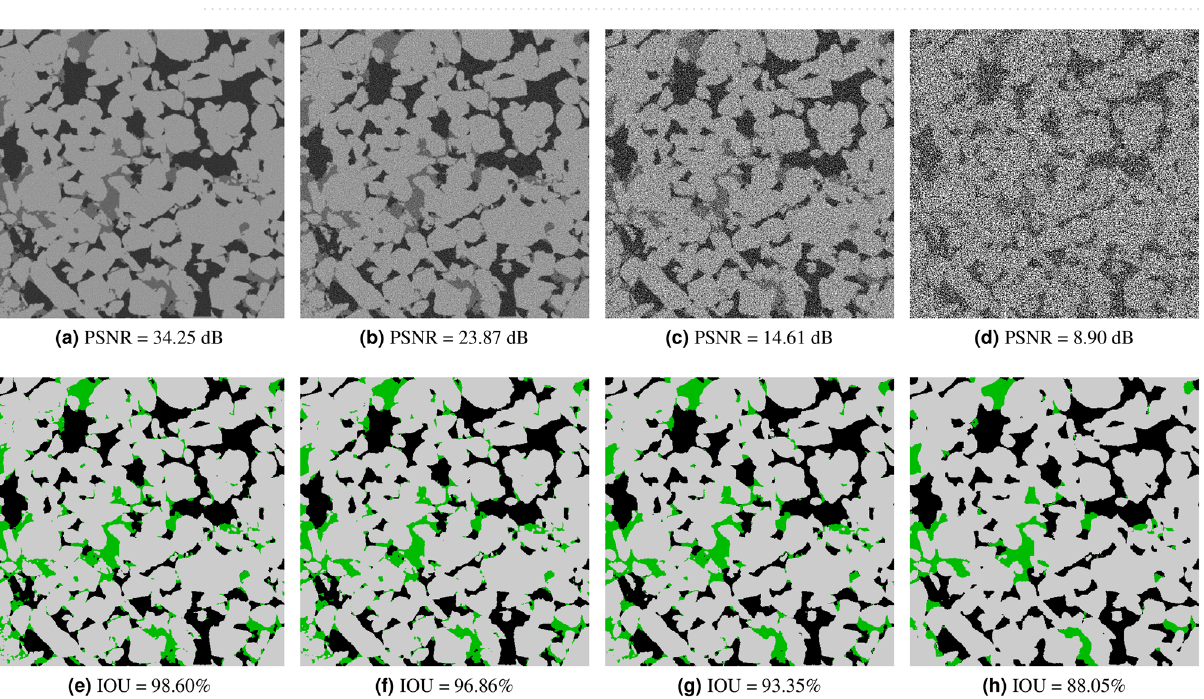
Figure 7. Segmentation results for the Reservoir sandstone on synthetic images generated with Gaussian noise